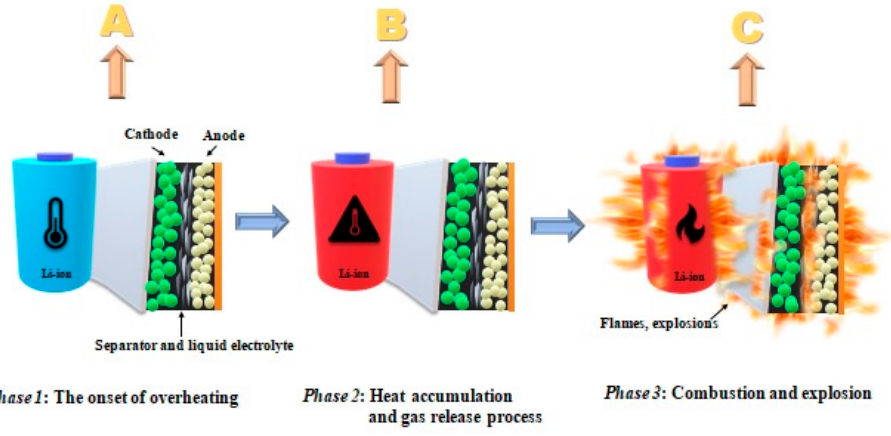
Figure 1. Three stages for the thermal runaway process. When the temperature rises significantly in the next step (B-2), various reactions can be